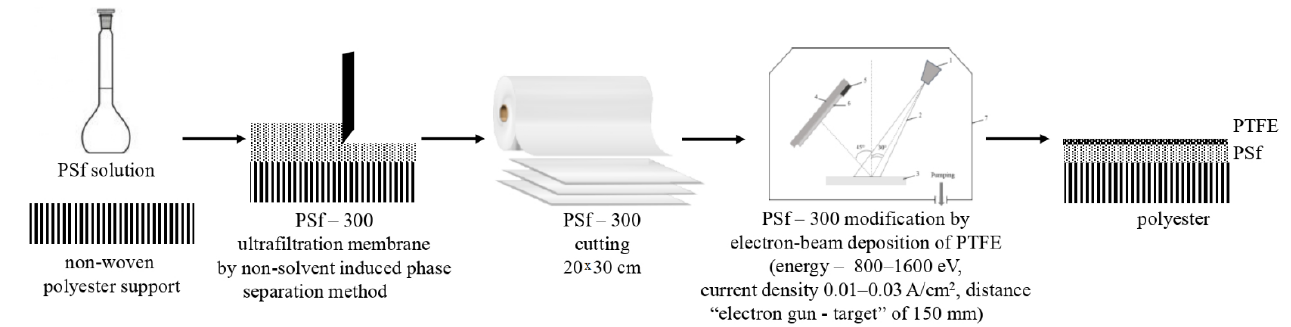
Figure 1. The principal schema of creation and modification of ultrafiltration polysulfone membrane.